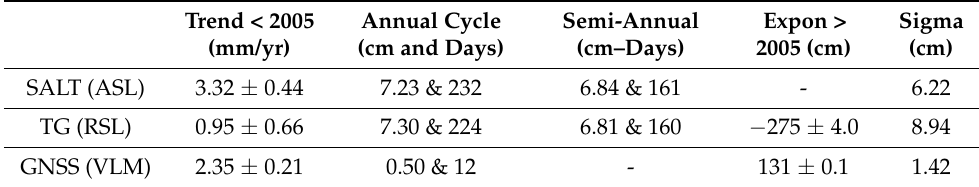
Table 3. Summary of the model fits through the SALT, TG and GNSS data. First column gives the trend in mm/yr before 2005, the 2nd column the annual cycle (amplitude in cm and phase in days after 1 January), the 3rd column the semi-annual cycle (again amplitude and phase), 4th column the amplitude of the exponential decay after 2005 in cm and the 5th column the residual RMS after the fit (in cm). Trend < 2005 Annual Cycle Semi-Annual Expon > Sigma (mm/yr) (cm and Days) (cm–Days) 2005 (cm) (cm) SALT (ASL) 3.32 ± 0.44 TG (RSL) 0.95 ±